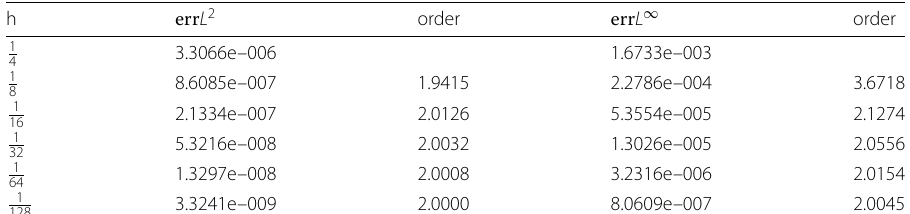
Table 4 The comparison of the l 2 -norm and the l ∞ -norm when τ = h x = h y for O ( h 2 x + h 2 y ) standard central difference scheme, at different values of the step size (for N = 4,8,16,32,64,128) in the x and y directions